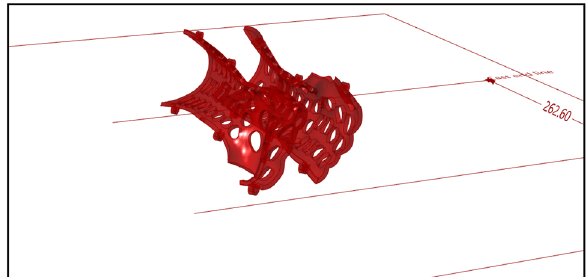
Fig. 10 Automatic print orientation algorithm result